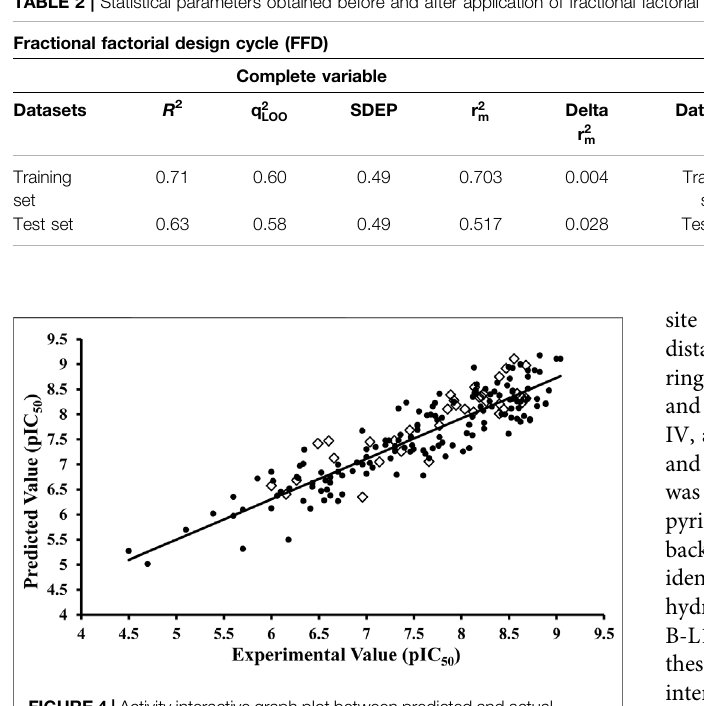
FIGURE 4 | Activity interactive graph plot between predicted and actual experimental activity values. The graph plot displays separate data series for training ( fi lled circles) and test (rhombus) set. R 2 for training set was observed as 0.82 and 0.77 for test